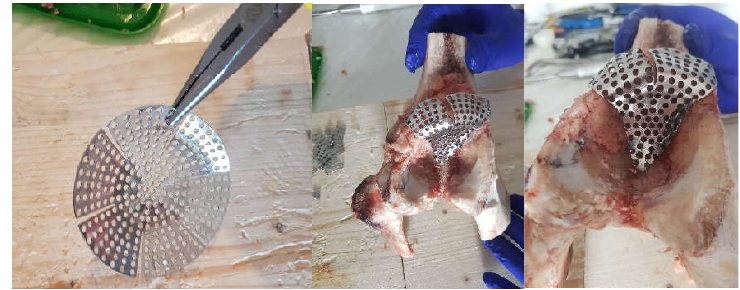
Figure 11. Positioning the reconstructive mesh.